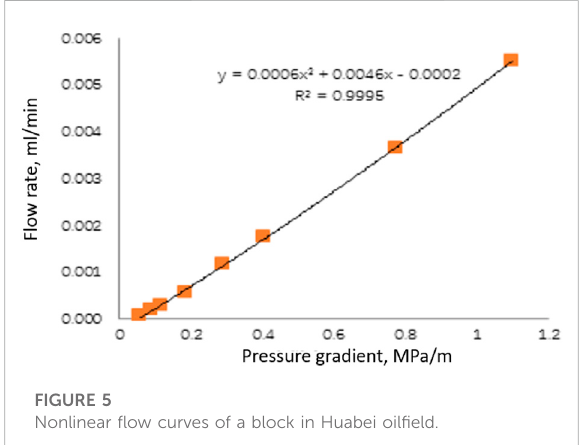
FIGURE 5 Nonlinear fl ow curves of a block in Huabei oil fi eld.